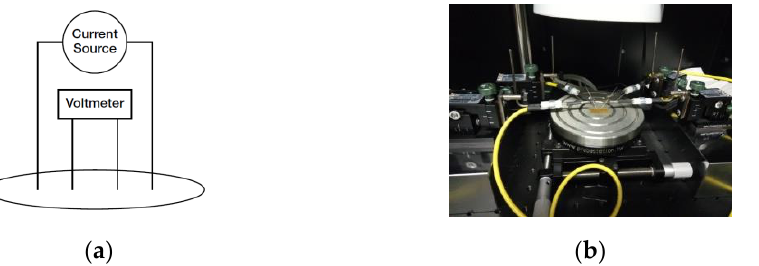
Figure 1. ( a ) Four-point collinear probe resistivity configuration and ( b ) photograph of the home- built dispositive used for the conductivity